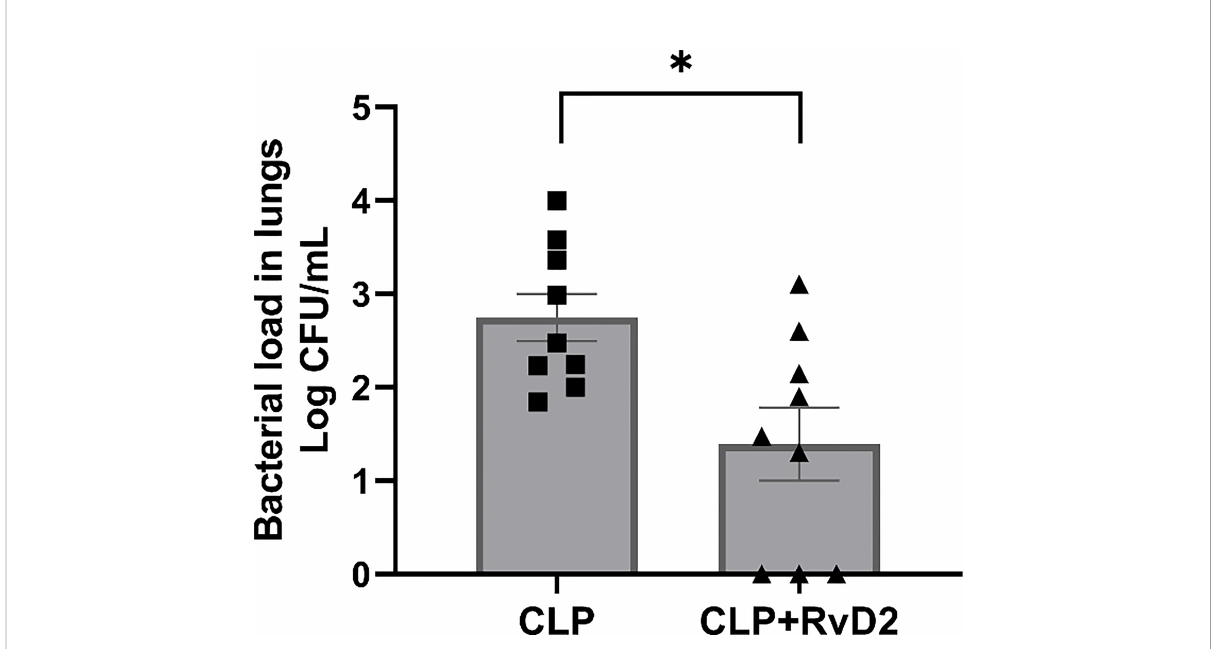
FIGURE 6 CLP surgery was performed on mice. Mice were given vehicle saline or RvD2 48h after surgery. 24h after injections, mice were given P. aeruginosa intranasally. 24h after the 2 nd hit with P. aeruginosa , mice were sacri fi ced and lungs lavaged. Lavage fl uid was serially diluted and plated on TSA plates. RvD2 administration reduced lung bacteria load. Data are mean ± S.E.M. *P<0.05 for n = 9 in all